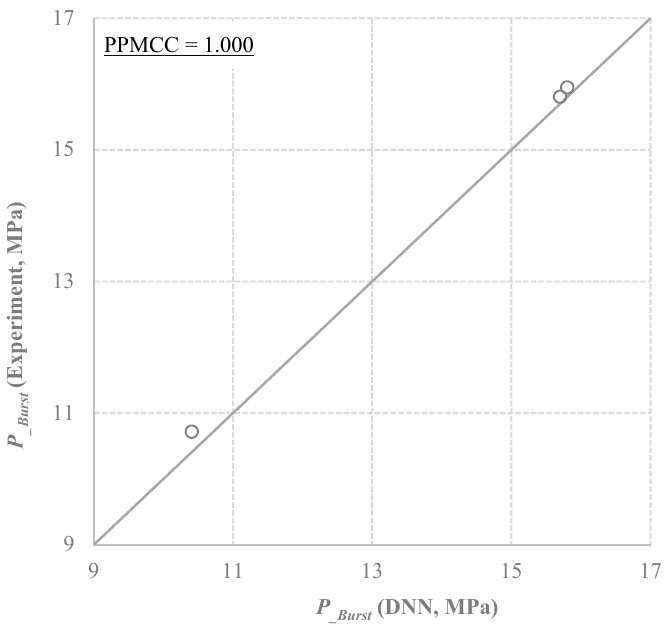
Figure 13. PPMCC between the burst pressure computed by the DNN model and the experimental results for the pipeline with a hemispherical dent.